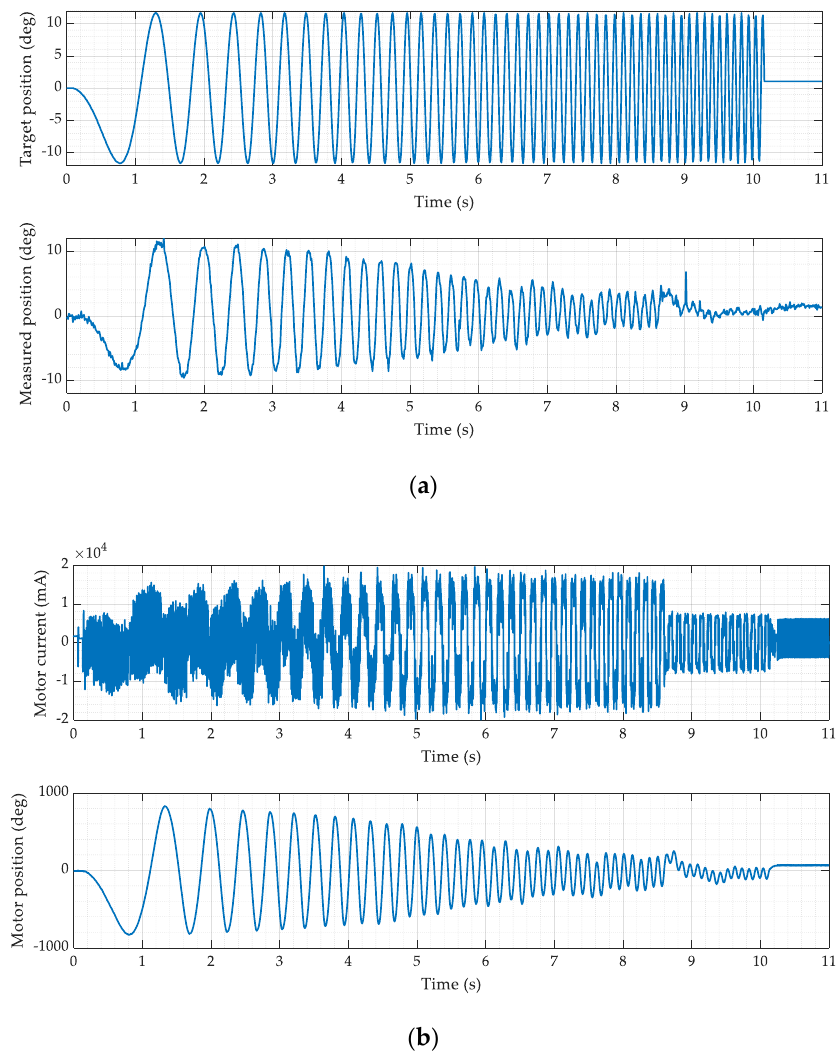
Figure 7. Sine-sweep steering maneuver—stationary vehicle on the ground, dry asphalt, 0–10 Hz, amplitude 10 degrees. ( a ) Reference steering wheel position and measured response by the steering encoder. ( b ) Measured motor current and position.